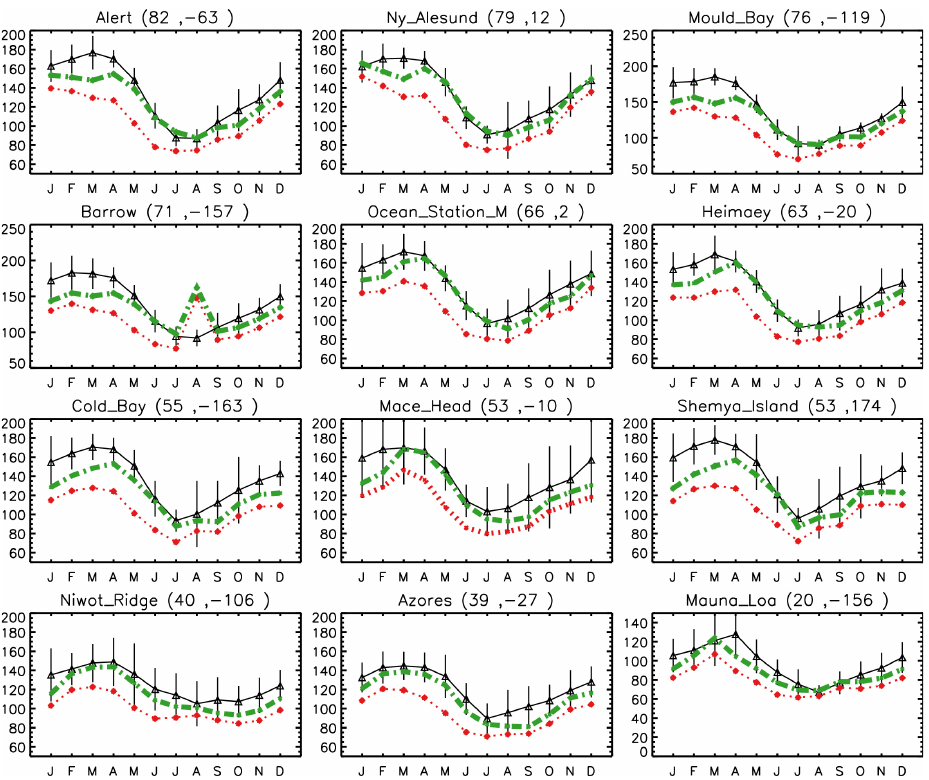
Fig. 5. Seasonal variation of CO concentrations at remote surface sites in northern extratropics. Climatological observations from NOAA/GMD (1988–2007) are shown in black. GEOS-Chem model values are shown in red with no HO 2 uptake and in green with γ (HO 2 ) = 1 producing H 2